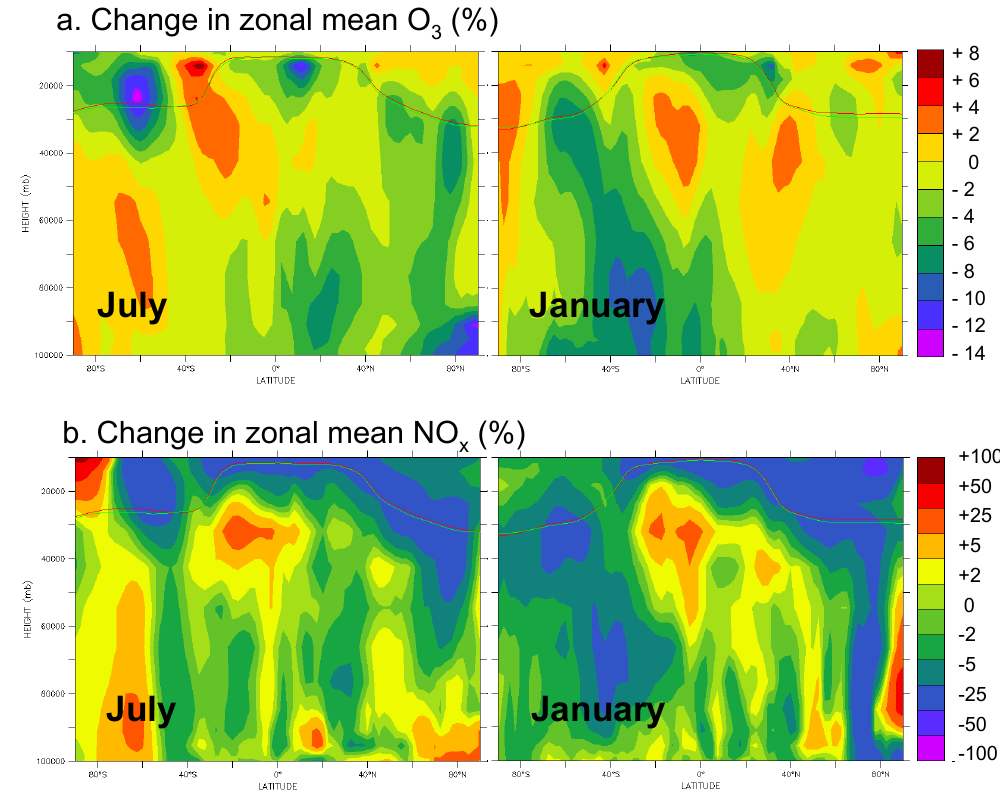
Fig. 9. Future change in O 3 (%) and NO x (%) zonal mean mixing ratio, for July (left) and January (right) conditions (A1B emission